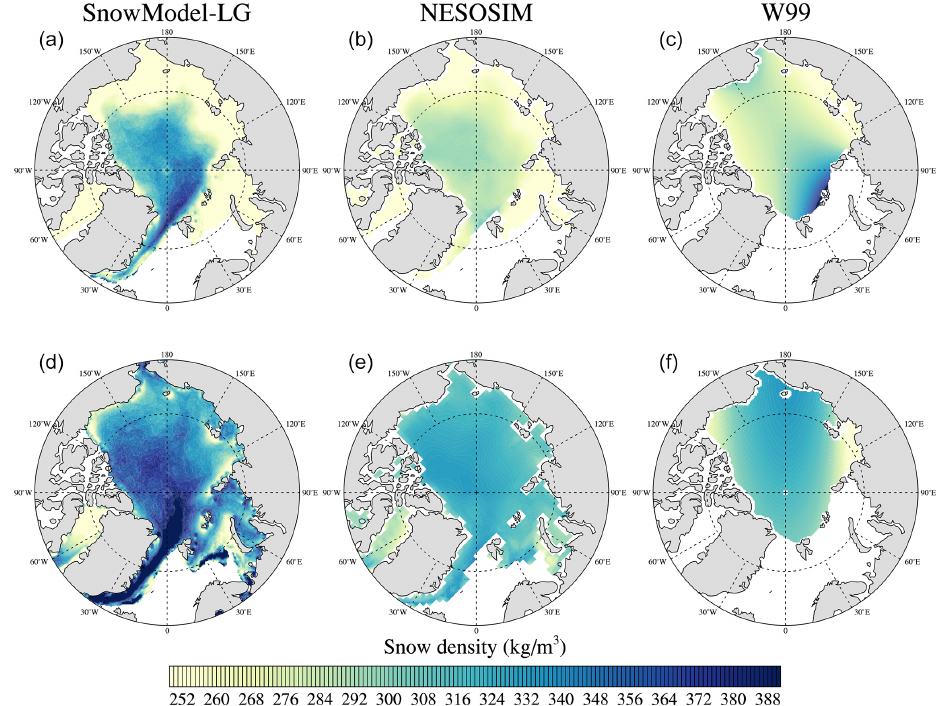
Figure 10. Mean snow density (units: kgm − 3 ) according to SnowModel-LG, NESOSIM and W 99 in November (a–c) and the next April (d– f) since 2000.